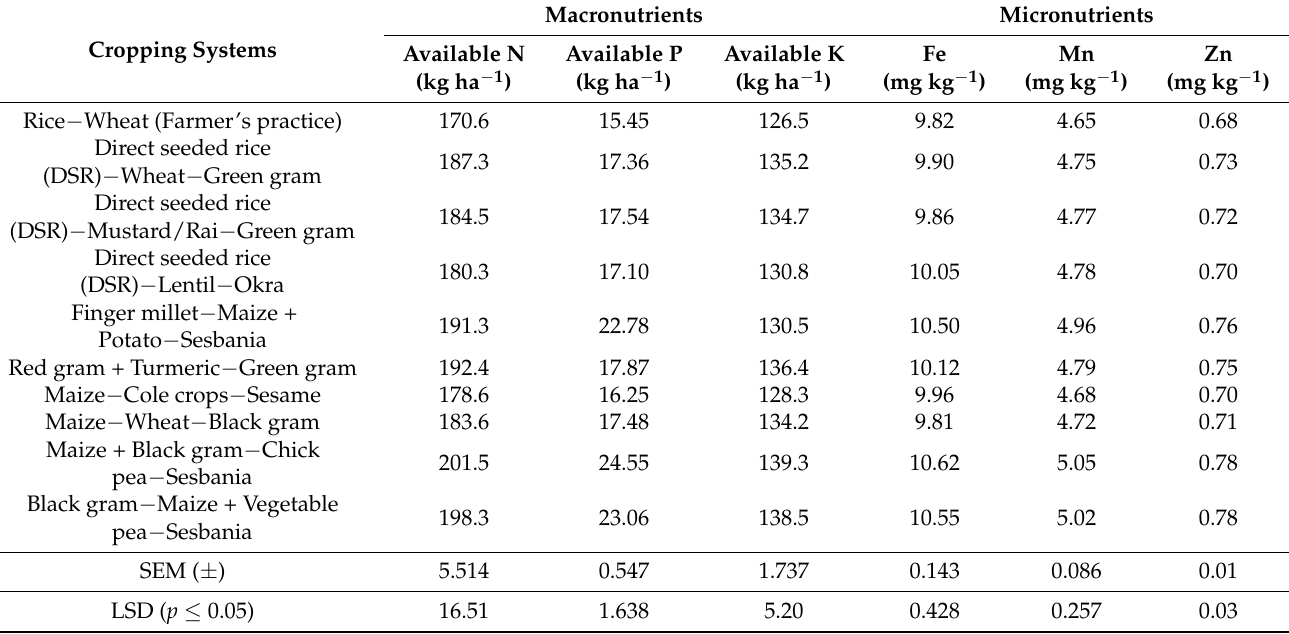
Table 8. Available N, P, K and DTPA extractable micronutrients in post-harvest soil of the diversified cropping